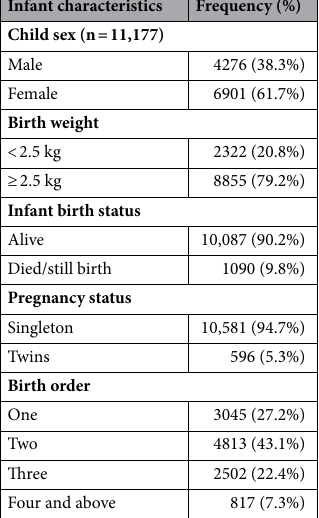
Infant characteristics